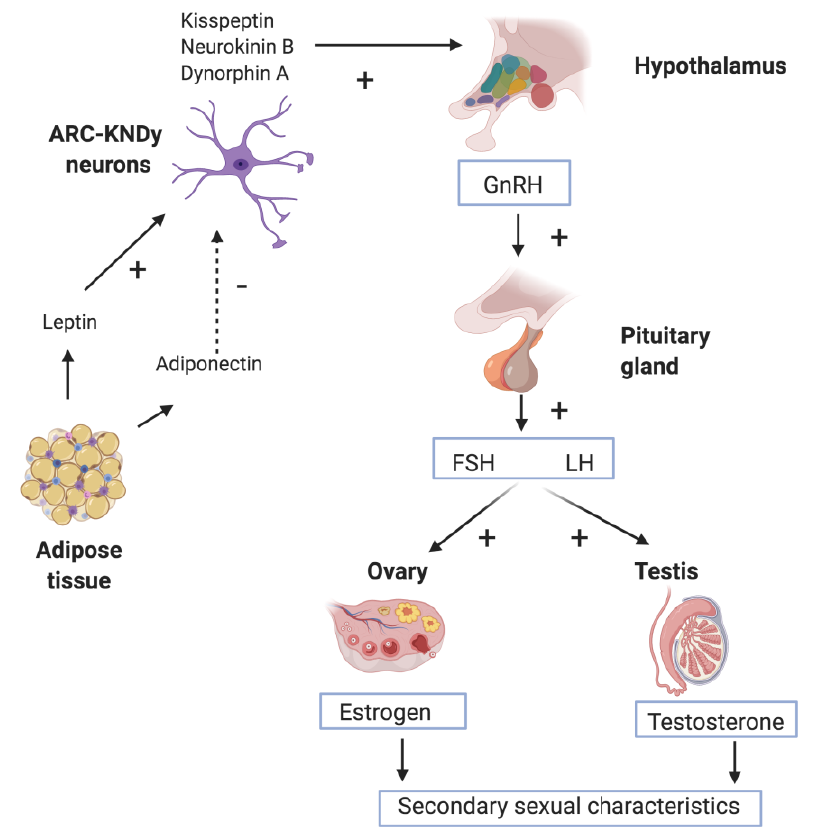
Figure 1. Stimulation of the hypothalamic-pituitary-gonadal (HPG) axis. The pulsatile release of hypothalamic gonadotropin-releasing hormone (GnRH) activates production and secretion of luteinizing hormone (LH) and follicle-stimulating hormone (FSH) by the pituitary gland, inducing gonadal production of estrogen and testosterone in girls. Onset of GnRH release is driven by a great number of different factors, including arcuate nucleus (ARC) kisspeptin/neurokinin B/dynorphin A (KNDy) neurons and adipokines. Created with BioRender.com.